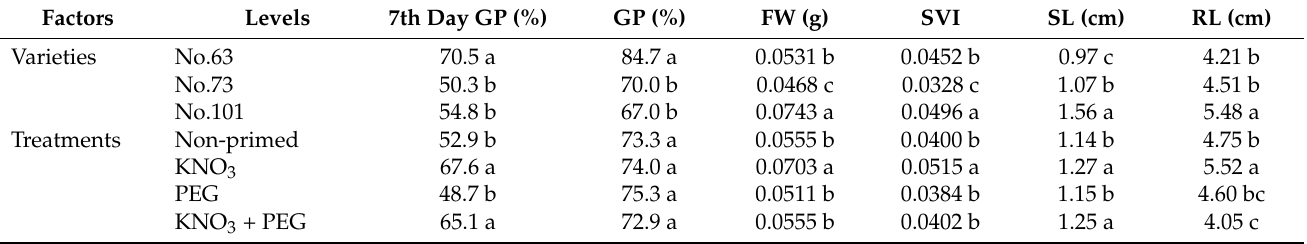
Table 2. The Tukey multiple comparison test result for the mean separations of different germination indexes at the 0.05